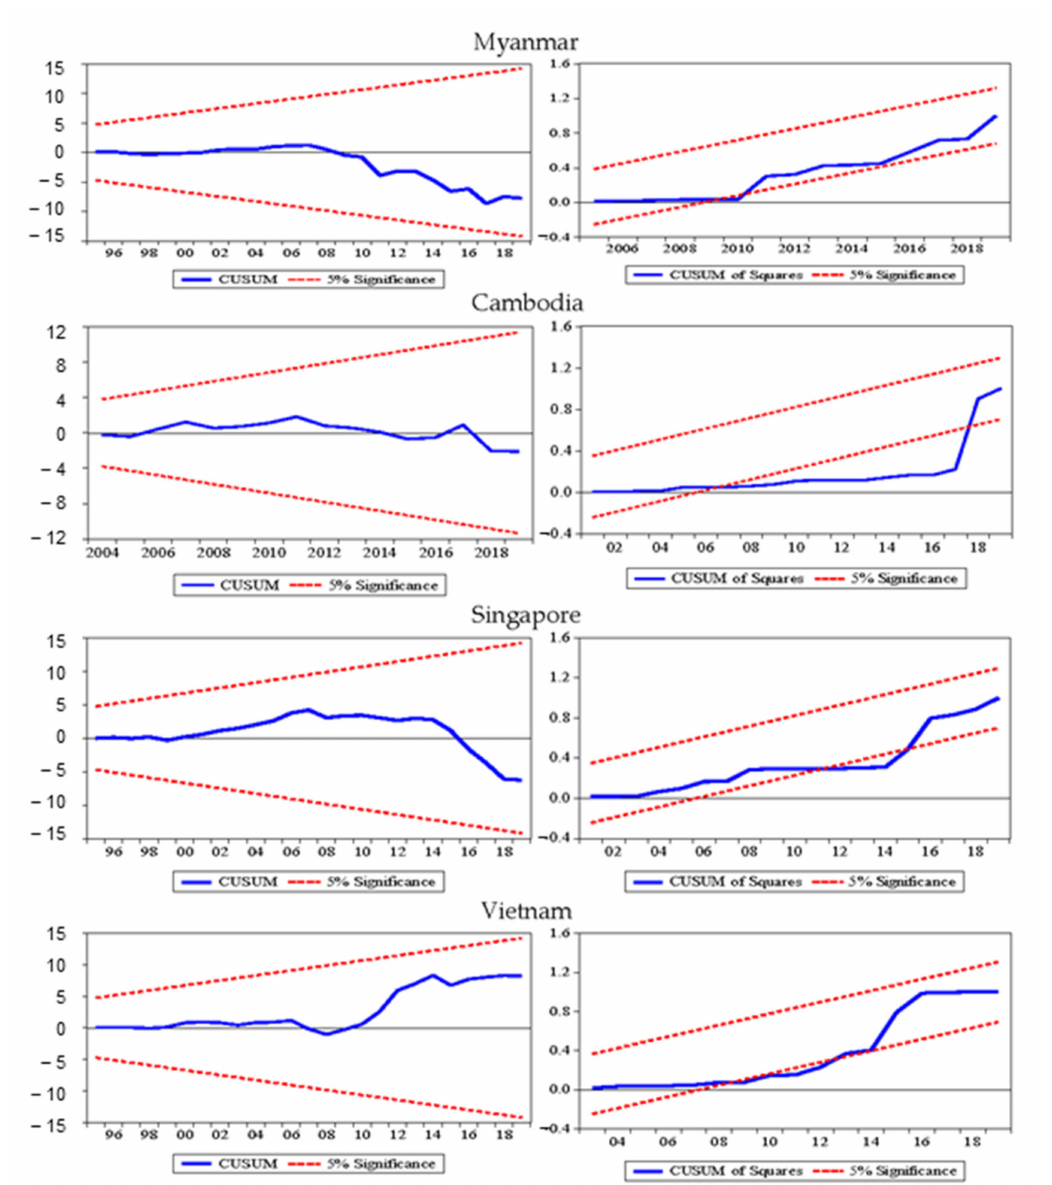
Figure 4. Cumulative sum and cumulative squares (CUSUM and CUSUMSQ) graph for structural breaks of the panel